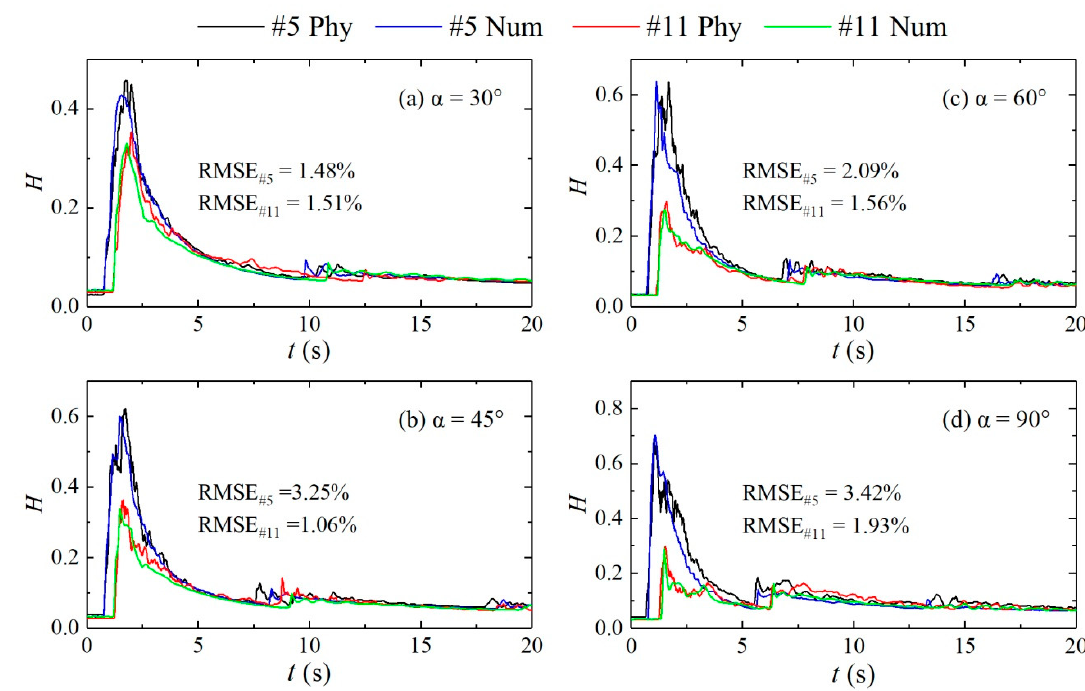
Figure 6. Comparisons of water depths at measuring points #4 and #10 from numerical simulation and experiment. ( a ): α = 30 ° ; ( b ): α = 45 ° ; ( c ): α = 60 ° ; ( d ): α = 90 ° .